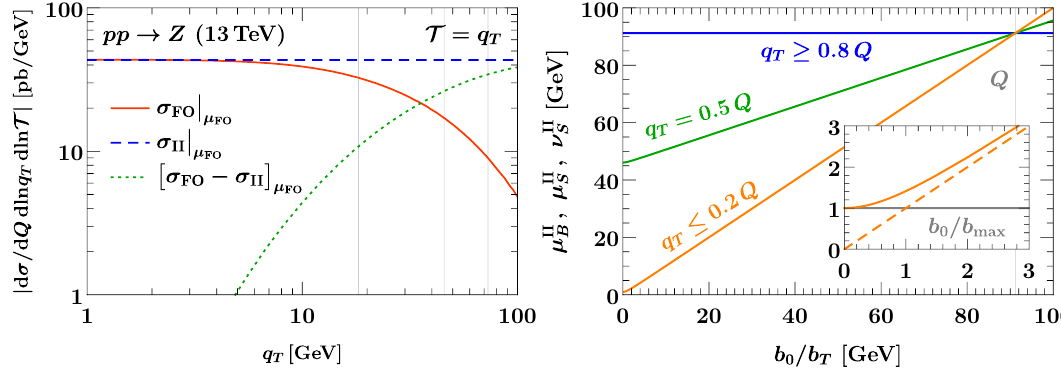
Figure 4 . Left: comparison of singular and nonsingular contributions to the (cid:12)xed O ( (cid:11) s ) double spectrum as a function of q T , with T = q T kept (cid:12)xed. The orange solid line shows the full QCD result and the dashed blue line the singular contributions contained in the SCET II result eq. (2.20). The dotted green line shows their di(cid:11)erence, which corresponds to the power corrections indicated in eq. (2.21). The thin vertical lines correspond to the transition points ( x 1 ; x 2 ; x 3 ) given in the text. Right: SCET II hybrid pro(cid:12)le scales as a function of b 0 =b T for representative values of q T . The thin vertical line in the main plot corresponds to Q . The inset shows the behavior of the pro(cid:12)le in the nonperturbative region b 0 =b T (cid:24) (cid:3) QCD , where the gray horizontal line indicates the scale b 0 =b max at which we freeze out the resummation. The dashed orange line in the inset indicates